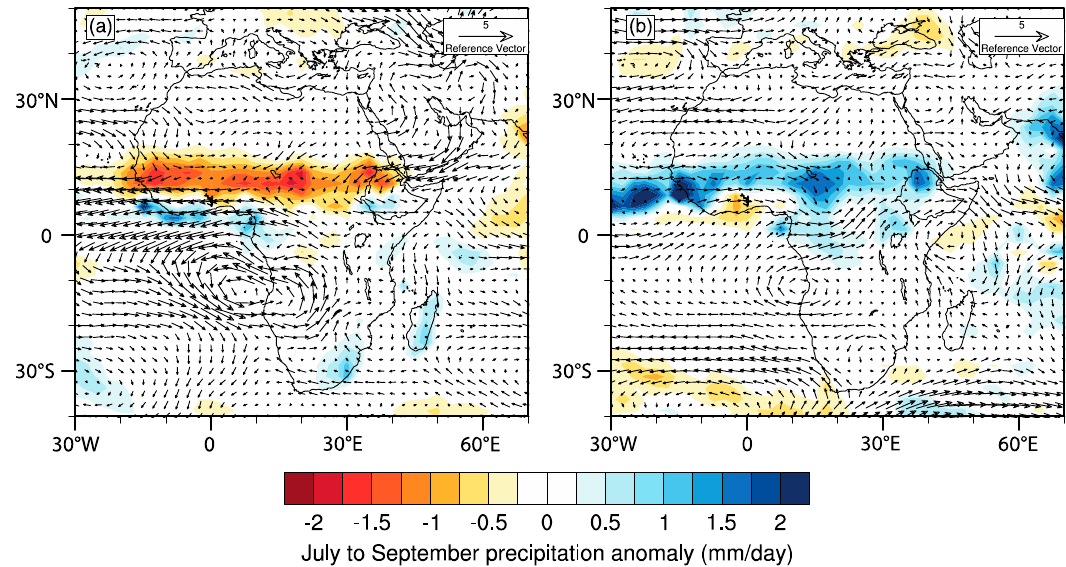
Figure 5. Composite maps of summer (July–September) anomalous vector wind at 850 hPa (reference vector given in m/s) and precipitation anomalies during the ( a ) driest and ( b ) wettest years in Afar and Amhara.